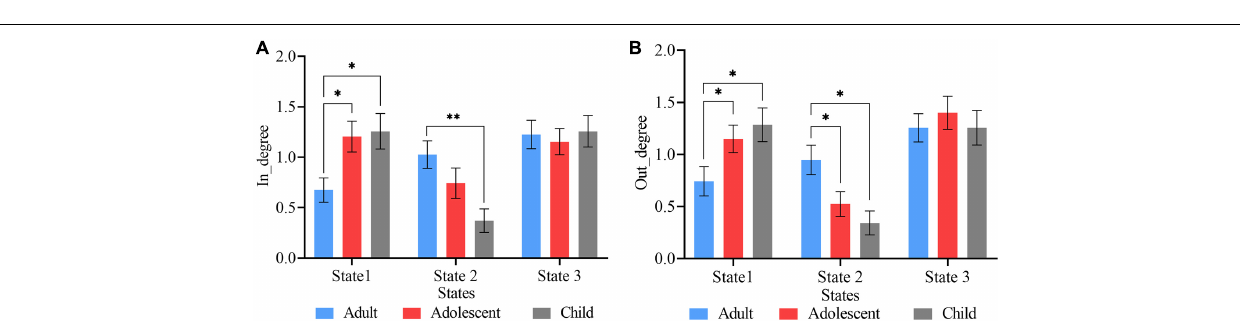
FIGURE 6 | State vectors degree of transitions. (A) Frequency of transitions into each state. State 1 showed significant differences in both adult vs. adolescent, and adult vs. child pairs, whereas, state 2 showed significant differences between only adult vs. child ADHD patients. (B) Frequency of transitions out of each state. States 1 and 2 showed significant differences between both adult vs. adolescent, and adult vs. child pairs. Asterisk indicates significant states ( p < 0.05, FDR corrected), two asterisks indicate significant differences with threshold p < 0.001, FDR